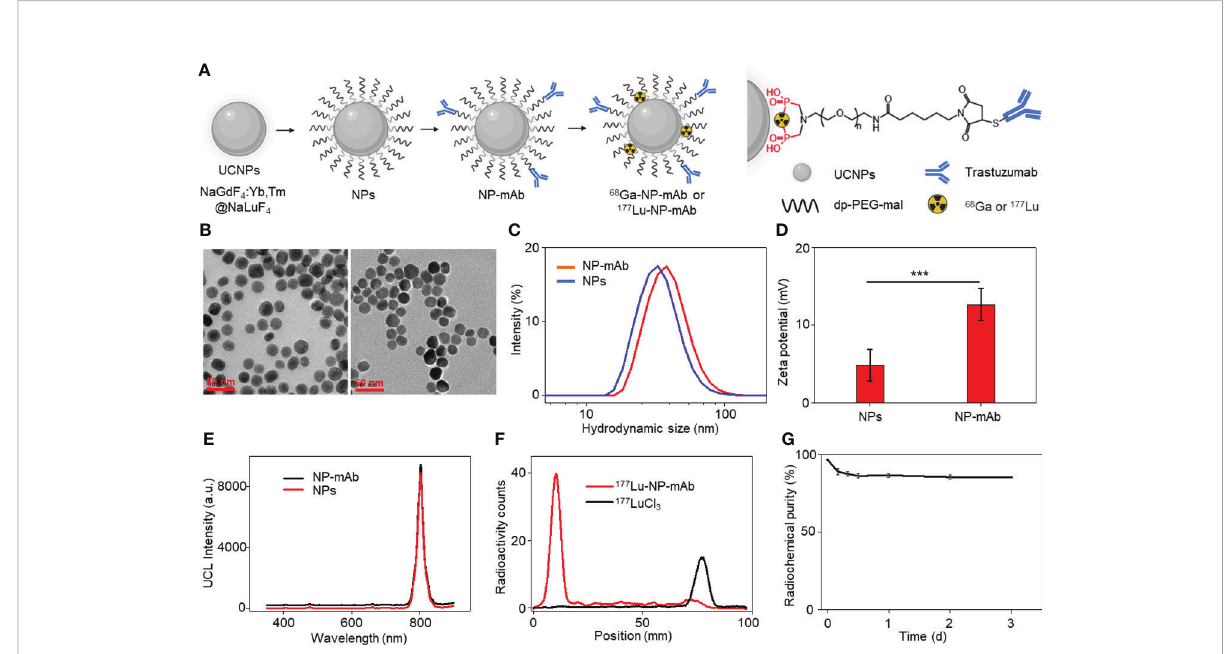
FIGURE 1 Synthesis and characterization of theranostic nanoplatform. (A) Schematic depicting the preparation of theranostic nanoplatform and structure diagram. (B) Transmission electron microscopy (TEM) image of NPs and NP-mAb nanoparticles. (C) Hydrodynamic size of NPs and NP-mAb in water determined by DLS. (D) Zeta potential of NPs and NP-mAb in water (***P< 0.001). (E) UV – vis spectra of NPs and NP-mAb under 980 nm light irradiation. (F) Radiochemical pure analysis of 177 Lu-NP-mAb and 177 LuCl 3 . (G) Radiolabeling stability of 177Lu-NP-mAb in PBS